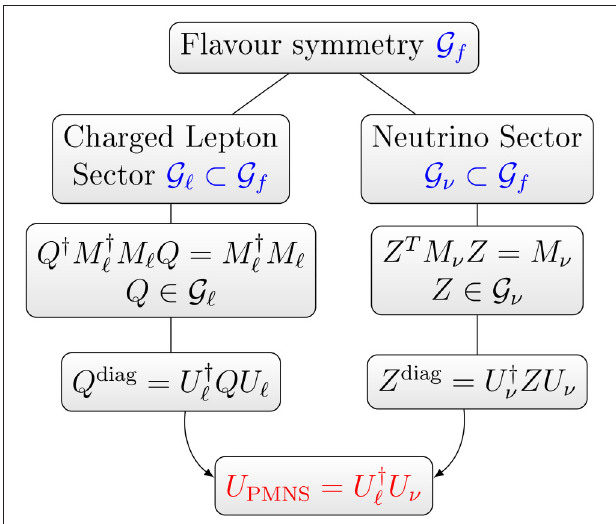
FIGURE 3 | Representative scheme of the approach used to construct the U PMNS